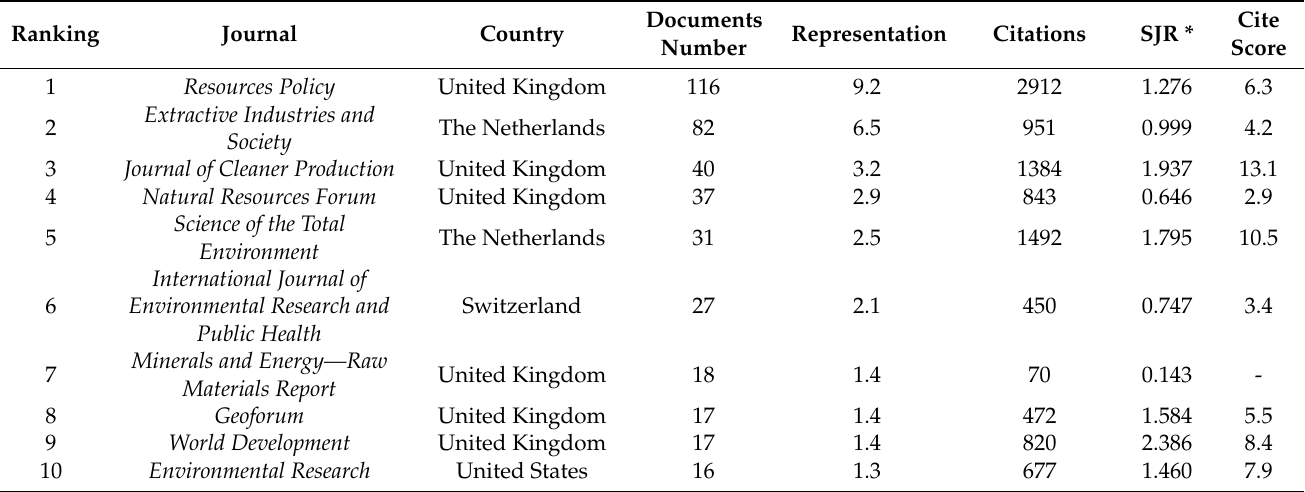
Table 2. Top 10 journals with the highest number of